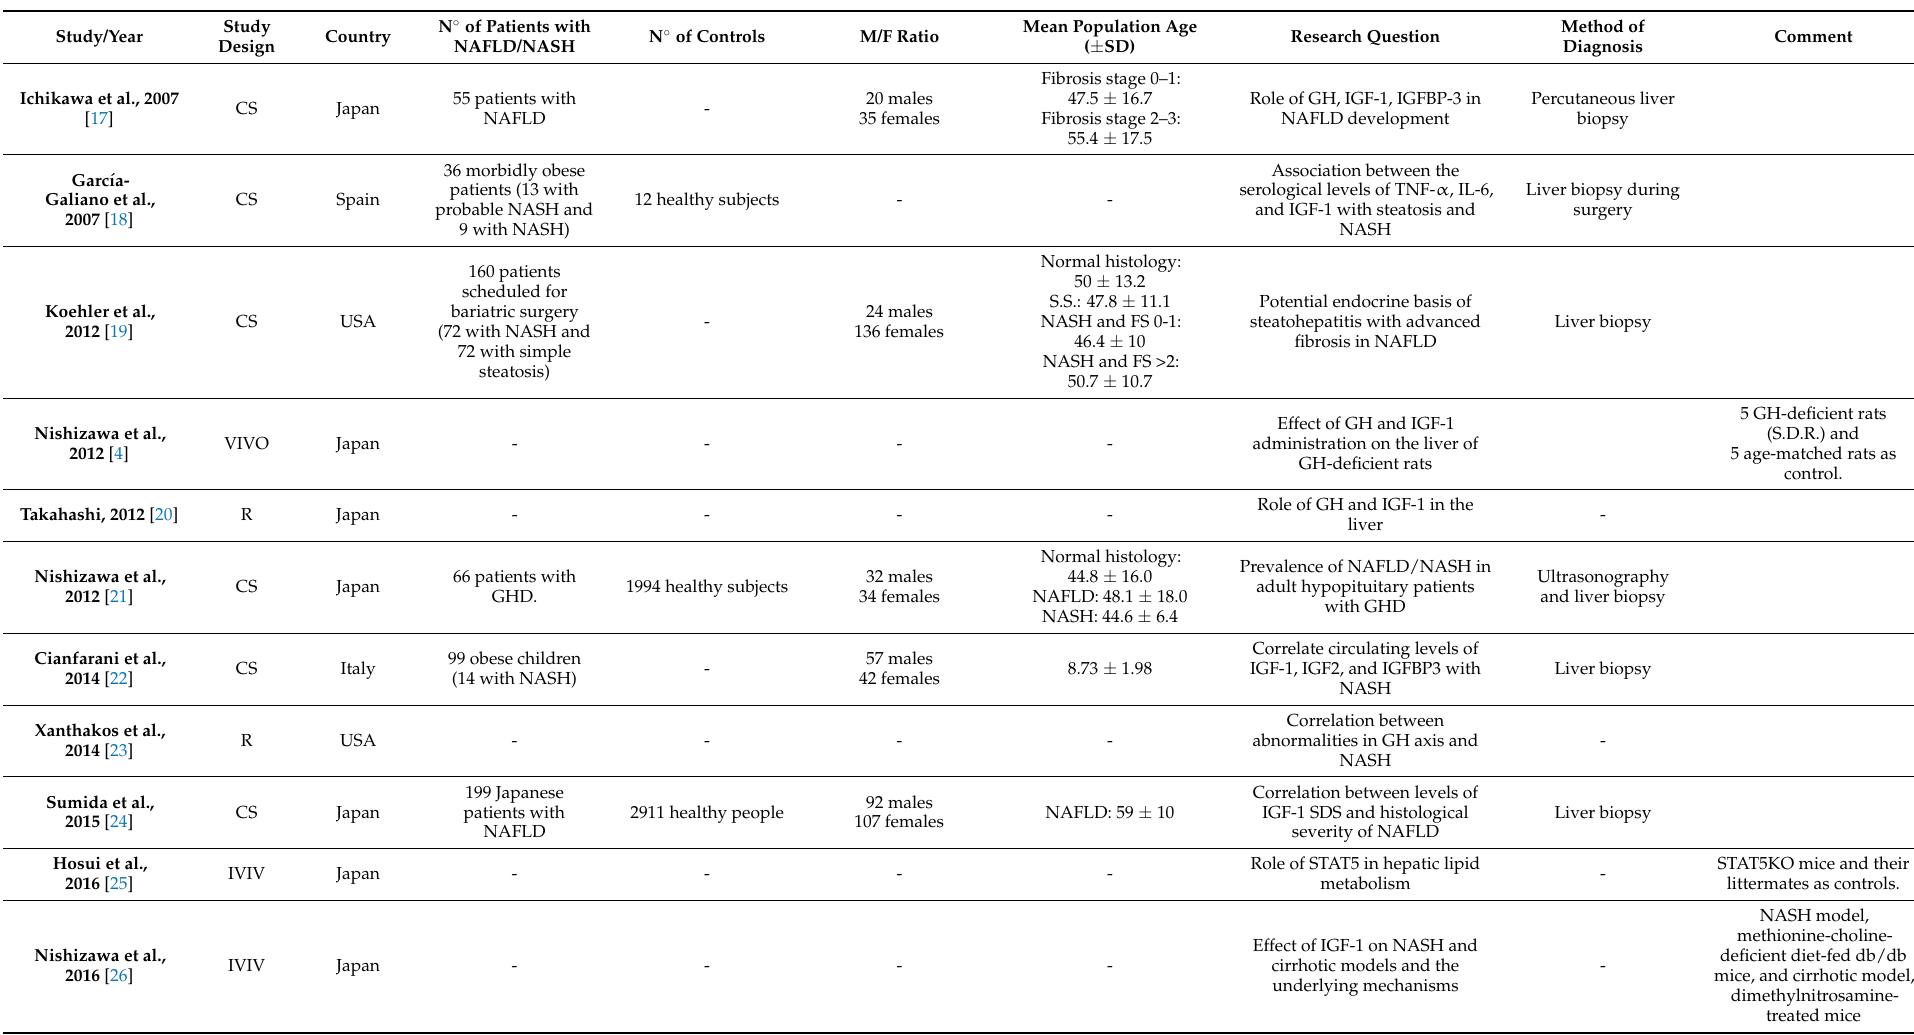
Table 1. Studies included in the systematic review assessing the relationship between NASH IGF-1 and